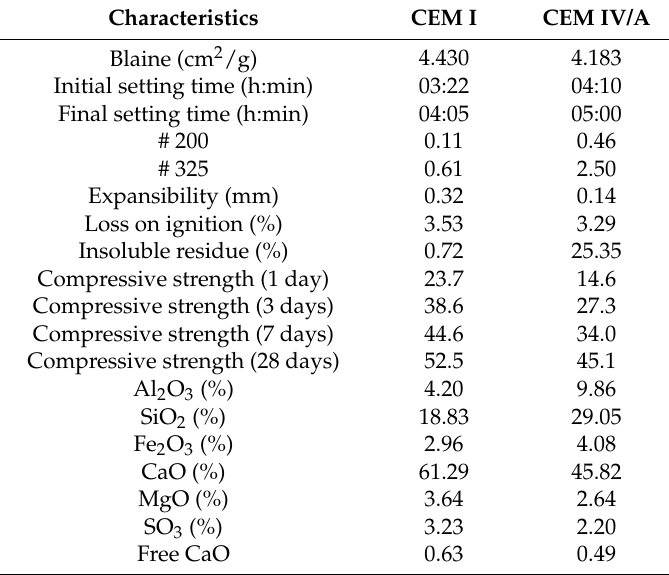
Table 1. Characteristics of the